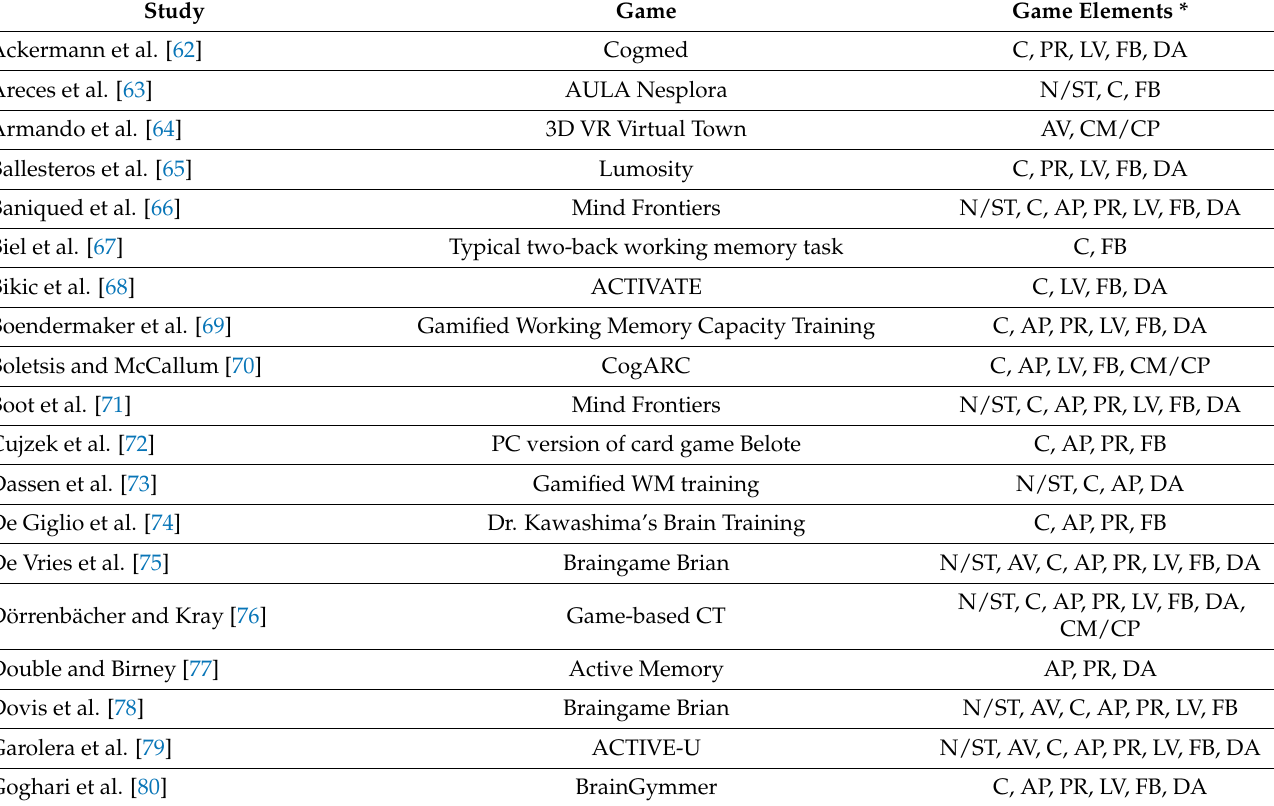
Table 2. Description of games and GEs of studies included in the systematic